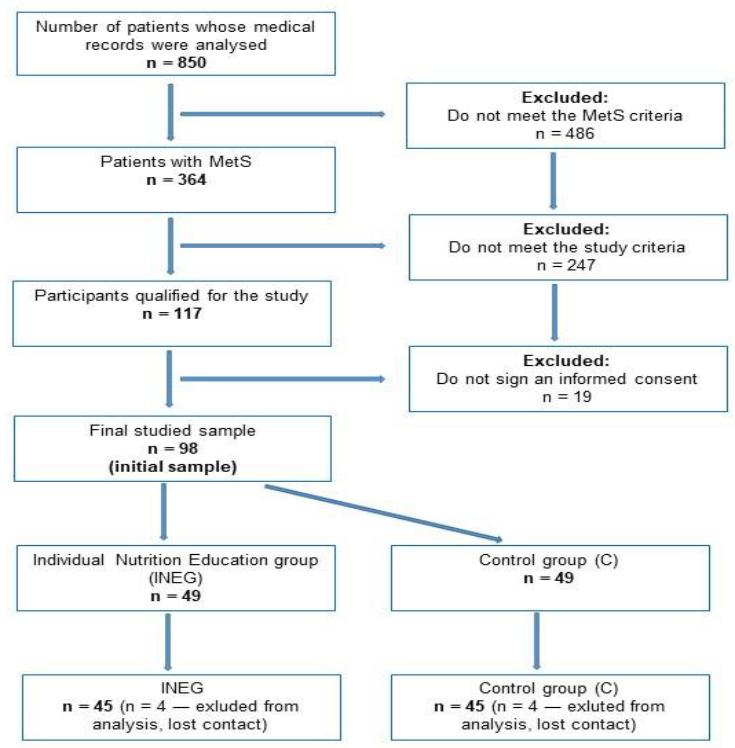
Figure 1. Flow-chart of study participants.